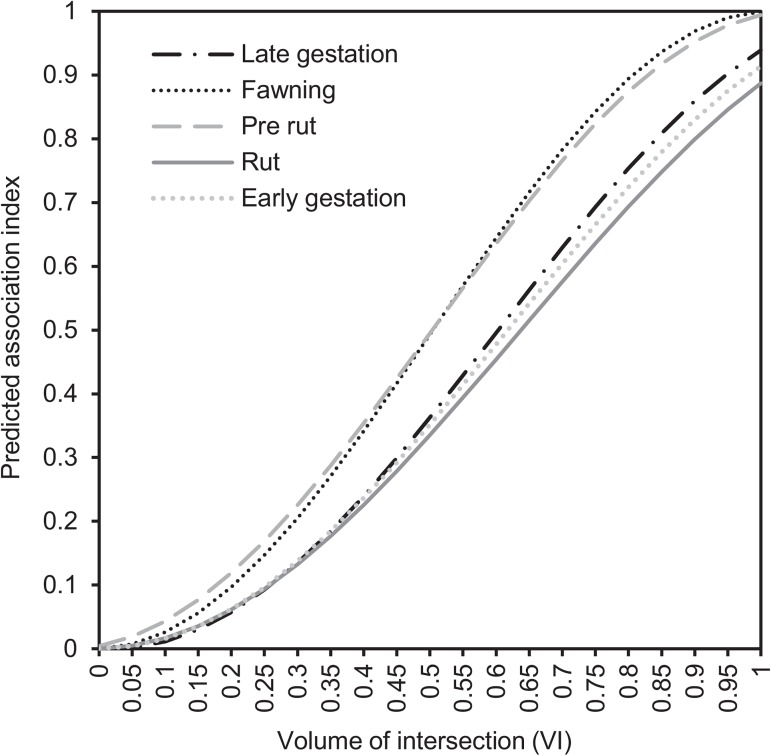
Seasonal predicted pairwise spatial association indices at different levels of volume of intersection (VI) among adult mule deer.No confidence intervals (CI) are shown to facilitate graph readability. For CI and observed values, see S4 Fig.